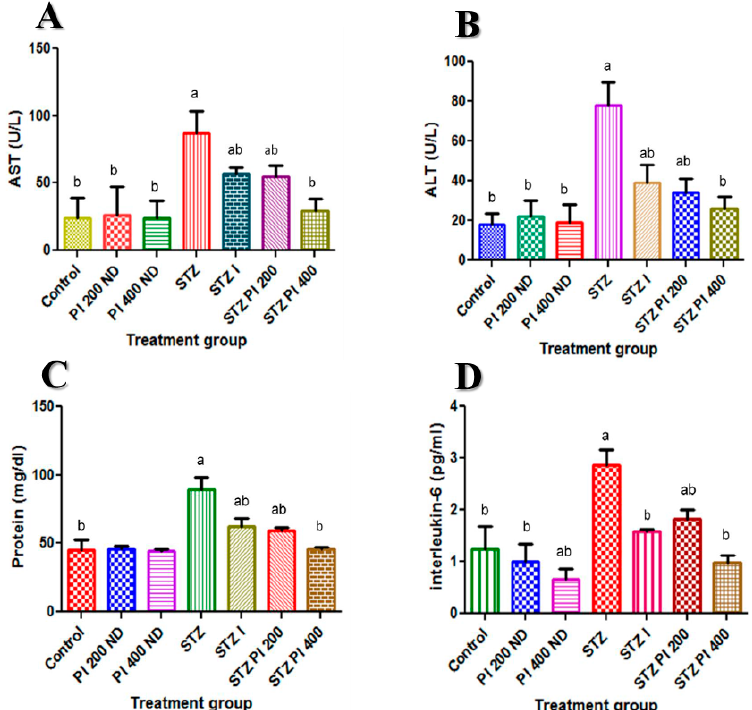
Figure 2. Effect of PBPi on serum liver function and serum interleukin-6 (IL-6). ( A ) AST (U/L), ( B ) ALT (U/L), ( C ) Protein (mg/dL), ( D ) Interleukin-6 (pg/mL). Data are presented as mean ± S.D. (n = 10). Mean differences are significant ( p < 0.05) when compared with: a control group, b STZ only.